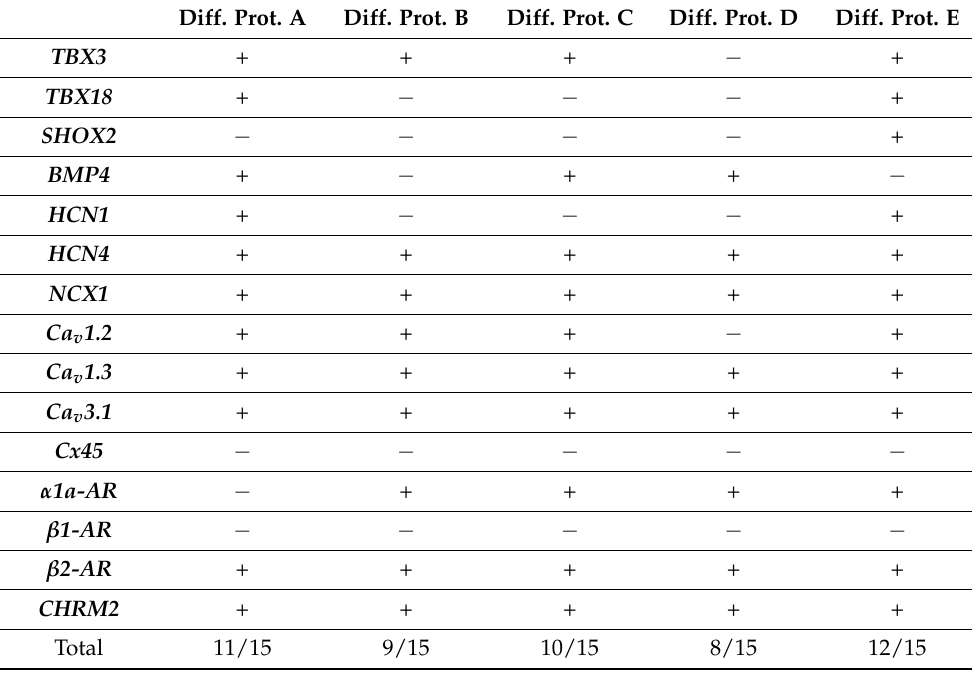
Table 1. Assessment of pacemaker-specific gene expression in cardiac pacemaker cells. Diff. Prot. A Diff. Prot.